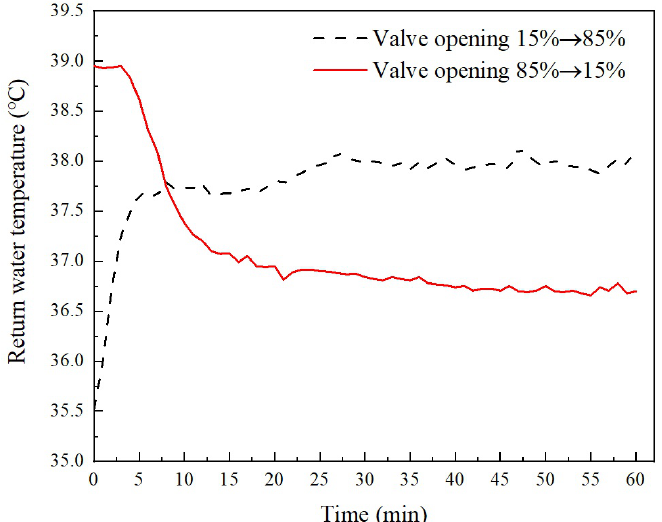
Fig. 11 Return water temperature change